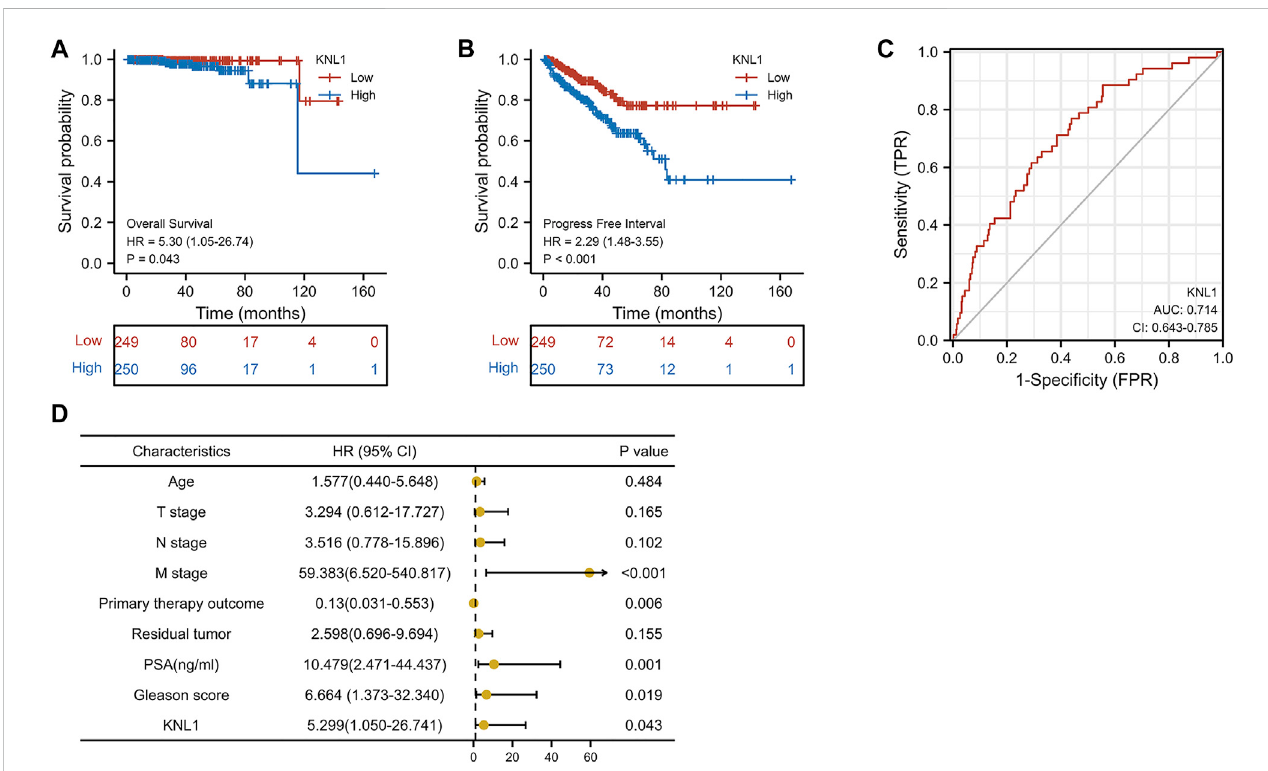
FIGURE 3 Correlation between KNL1 and the prognosis. KNL1 expression was signi fi cantly negatively correlated with OS (A) and PFI (B) in TCGA. (C) Receiver operating characteristic (ROC) curve for KNL1 expression in PRAD. (D) Forest map of KNL1 expression and other clinicopathological